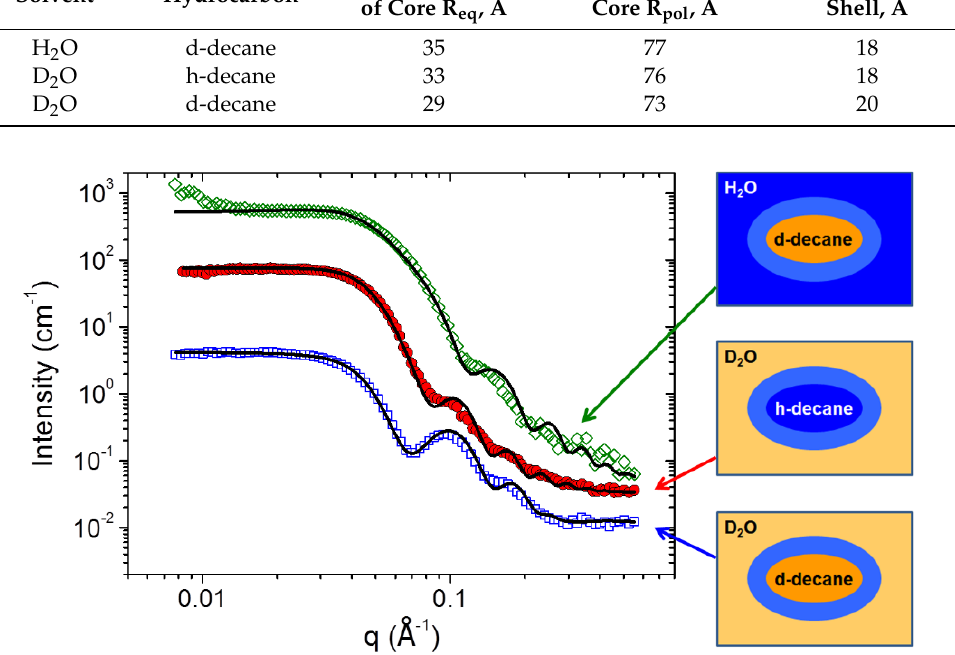
Figure 5. Scattering curves for 117 mM C8TAB and 78 mM potassium oleate solutions containing 210 mM of d-decane in H 2 O (diamonds), h-decane in D 2 O (circles) or d-decane in D 2 O (squares), at 20 °C. Solid lines represent fits of the scattering curves by a form factor of a charged core-shell ellipsoid (parameters of the fits are presented in Table 2).